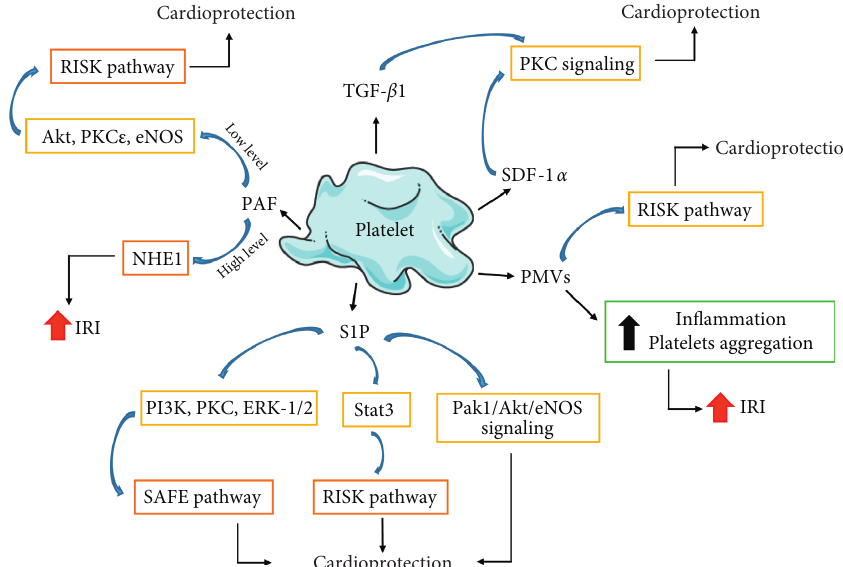
Figure 2: Cardioprotective role of platelets in ischemia/reperfusion injury (IRI). S1P can exert cardioprotection by activating RISK and SAFE-pathway, including activating kinases PI3K, PKC, ERK-1/2, and Stat3, respectively. Moreover, S1P triggers cardioprotection by activation of Pak1/Akt/NOS3 signaling. Cardioprotective effect for TGF- β 1 and SDF1- α is based on PKC signaling activation. PAF and PMVs have a dual effect on cardiac IRI. In the case of PAF, this effect depends on the level of PAF. RISK: reperfusion injury salvage kinases, SAFE: survivor activating factor enhancement, Akt: protein kinase B, ERK: extracellular signal-regulated kinase, Pak1: P21-activated kinase; PKC: protein kinase C, PI3 K: phosphatidylinositol 3-kinase, Stat3: signal transducer and activator of transcription 3, eNOS: endothelial nitric oxide synthase, NHE1: Na(+)/H(+) exchanger isoform 1, S1P: sphinosine-1-phosphate, SDF-1 α : stromal cell derived factor-1 alpha, TGF- β 1: transforming growth factor beta 1. The blue arrows indicate activation of the signaling path shown. The server https://smart.servier. com was used to create a